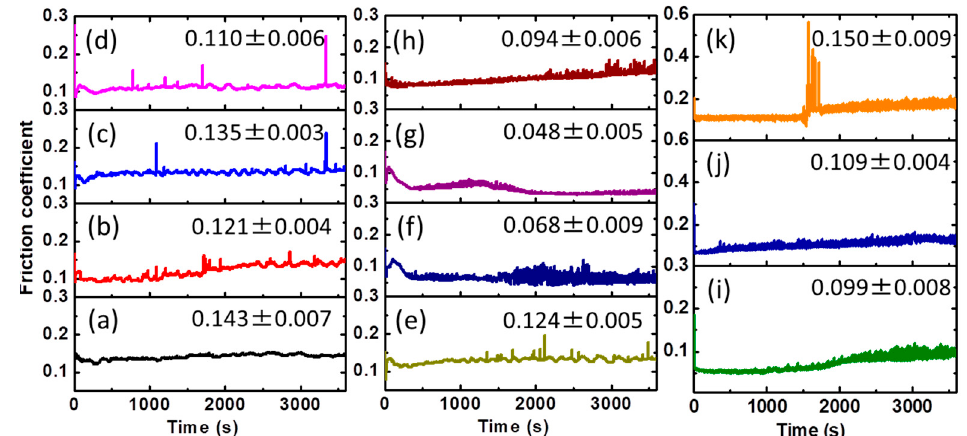
Figure 4. Friction coefficient while lubricating by EG/lignin lubricants. Load: 2.5 GPa, testing duration: 1 h, temperature: 25 °C. ( a ): EG; ( b ): EG-17BL; ( c ): EG-17SL; ( d ): EG-29BL; ( e ): EG-29SL; ( f ):